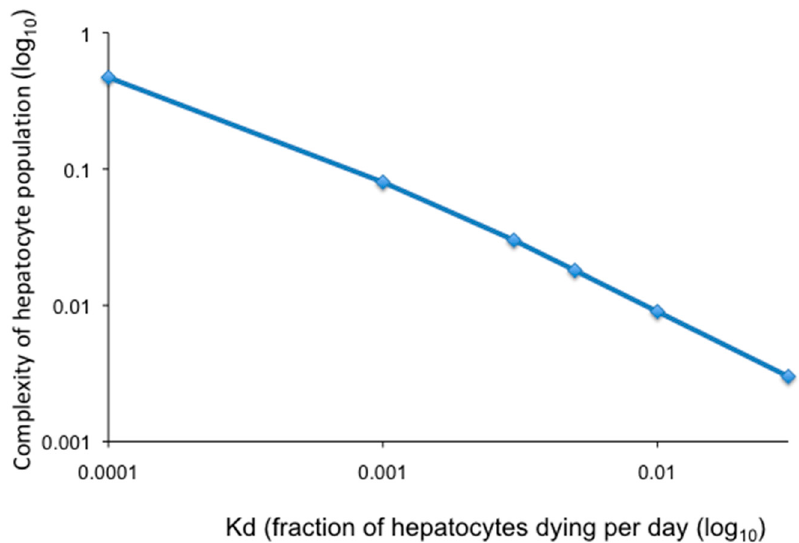
Figure 3. Changes in the complexity of the hepatocyte population after 30 years where all hepatocytes contribute equally to homeostasis (Model 4). Loss of complexity of the hepatocyte population was calculated using the program comp10 [11], assuming the indicated fraction of hepatocytes dying per day (Kd) over a period of 30 years, beginning when the liver reached full size. Declines in complexity are relative to the complexity when the liver first reaches full size. Calculations were made for Kd = 0.0001, 0.001, 0.003, 0.005, 0.01, and 0.03, respectively, as indicated by the diamonds in the plot.